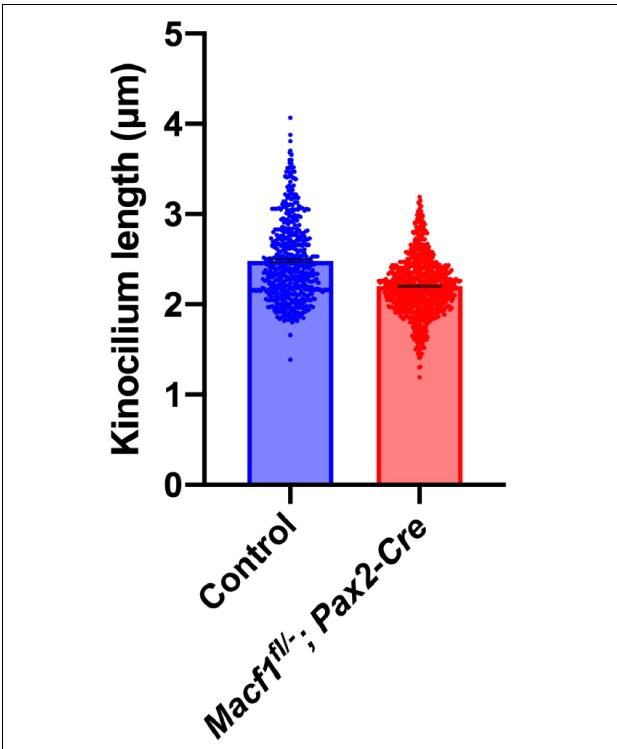
FIGURE 4 | Kinocilium length measurements of Macf1 fl / − ; Pax2-Cre and sibling control mice. Bar graph depicts mean lengths of outer hair cell kinocilia from the apical cochlear turns of P5 mice. The control group’s (blue; Macf1 fl / − ) mean kinocilium length is 2.49 ± 0.02 µ m ( n = 527 hair cells from 3 cochleae from 3 mice). The mean length for the conditional knockout group (red) is 2.20 ± 0.01 µ m ( n = 766 hair cells from 3 cochleae from 3 mice). P < 0.0001 calculated using an unpaired Student’s t -test.